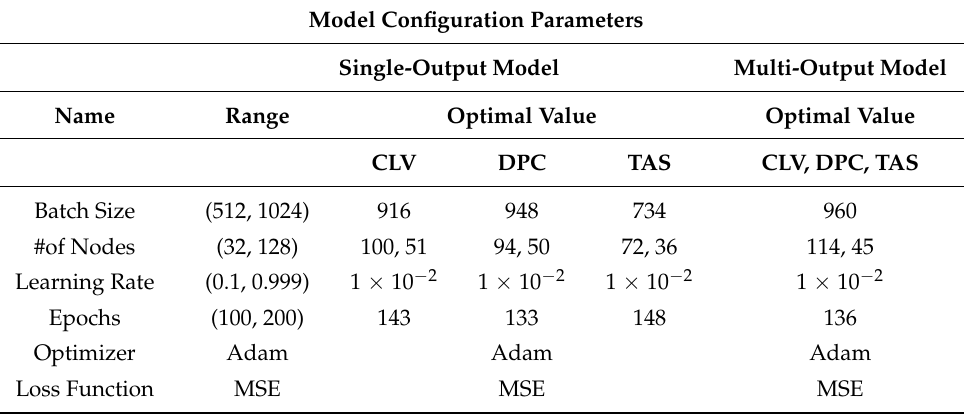
Table 1. Optimal hyperparameters and range of hyperparameters for DNN models.